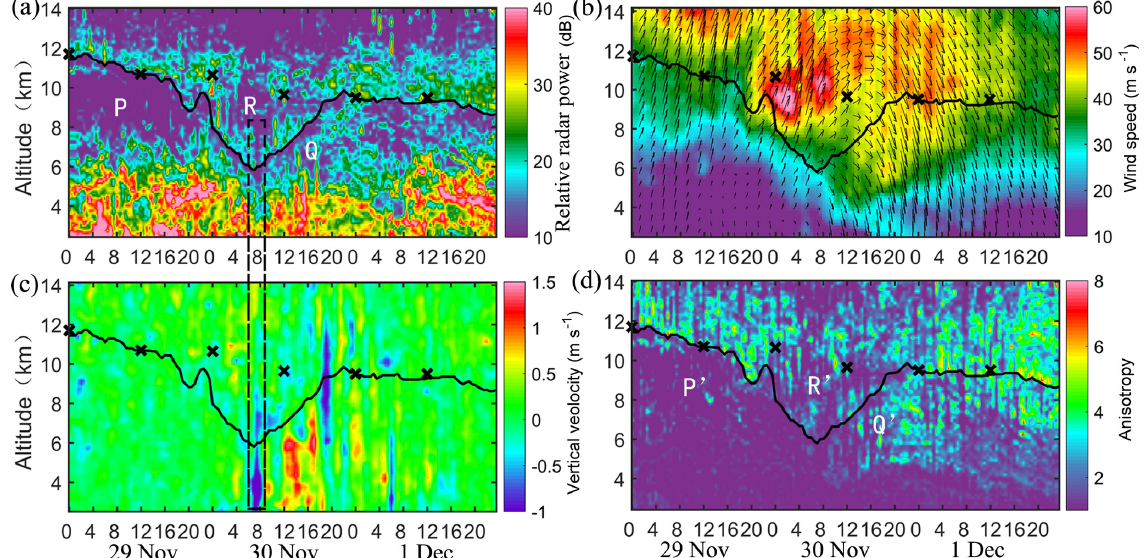
Figure 5. Altitude–time section of (a) the radar backscattered echo power in zenith direction, (b) the horizontal wind speed along with wind vector, of which the up and down arrows represent north and south, respectively, and left–right is west–east, (c) the vertical velocity, and (d) the aspect sensitivity, observed by the Beijing MST radar from 29 November to 1 December 2014. The black curve shows the radar-determined tropopause, as defined in Sect. 2.1. The dotted rectangle highlights the strong downdrafts immediately preceding the rapid tropopause ascent. The positions of the LRT tropopause heights, derived from the nearly simultaneous collocated GPS radiosonde temperature profile, are marked by crosses.